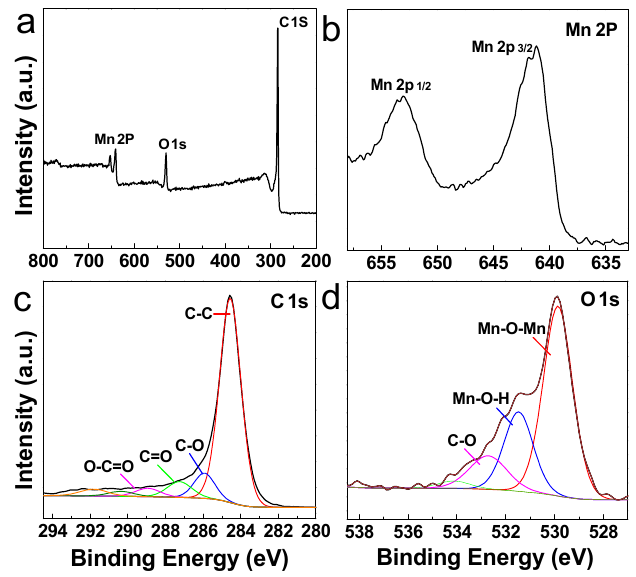
Figure 3. ( a ) X-ray photoelectron spectroscopy (XPS) survey spectrum of CNF/MnO x -4. ( b – d ) XPS high-resolution spectra of Mn 2p, C 1s, and O 1s.